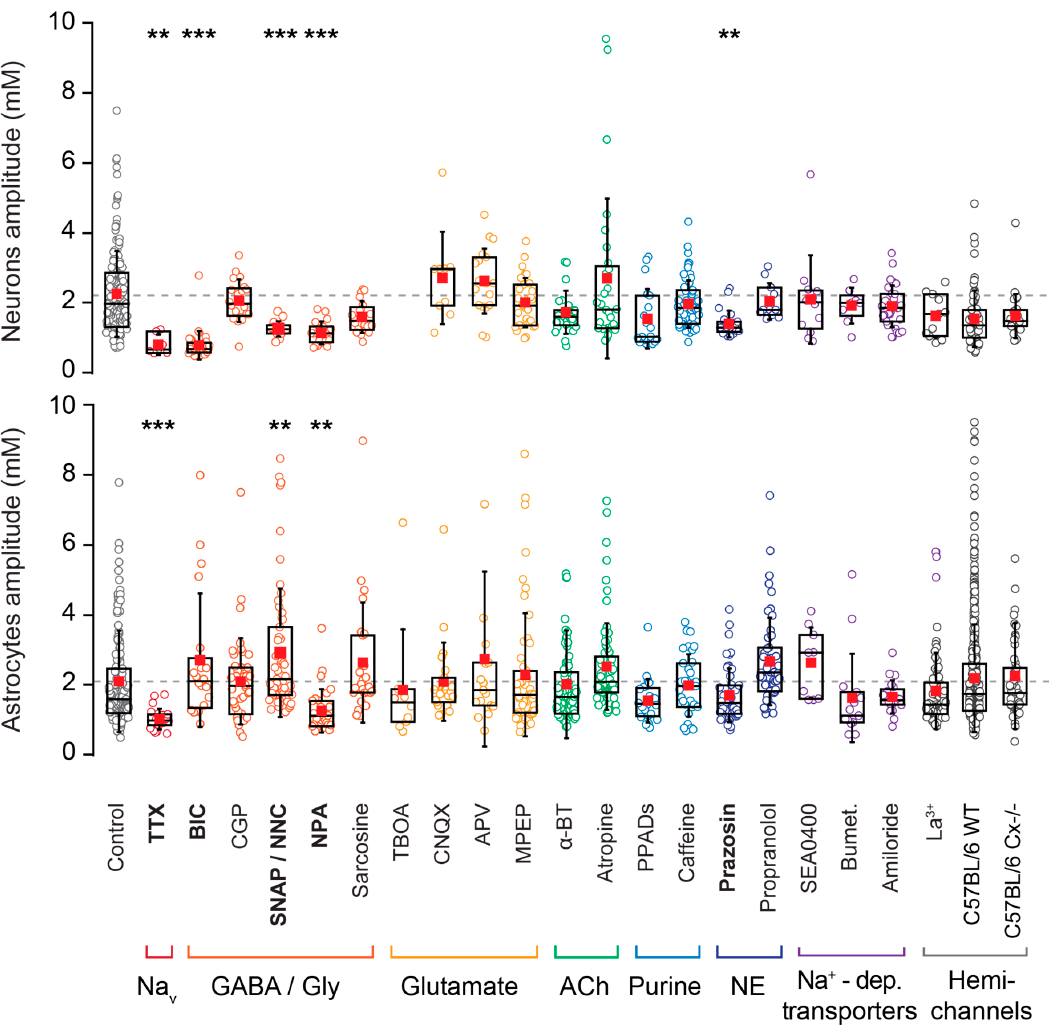
Figure 5. Pharmacological investigation. Comparison of the fluctuation amplitudes in neurons and astrocytes in the presence of various pharmacological conditions, as detailed in Tables 1 and 2. Blockers are arranged into color groups according to their target pathway, as indicated below the plots. Abbreviations, see Table 1. Bumet: bumetanide; a-BT: a-bungarotoxin. One data point (10.95 mM)